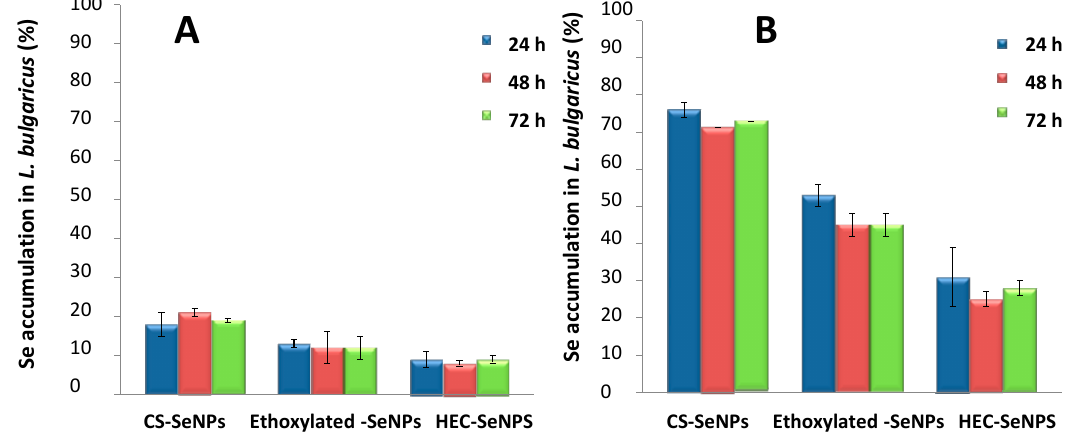
Figure 4. Selenium accumulation in bacteria in presence of SeNPs at two level of exposure ( A ) 1 µ g Se mL − 1 and ( B ) 10 µ g Se mL − 1 at different times of exposure. Data are expressed as mean ± standard error N = 3 replicates.